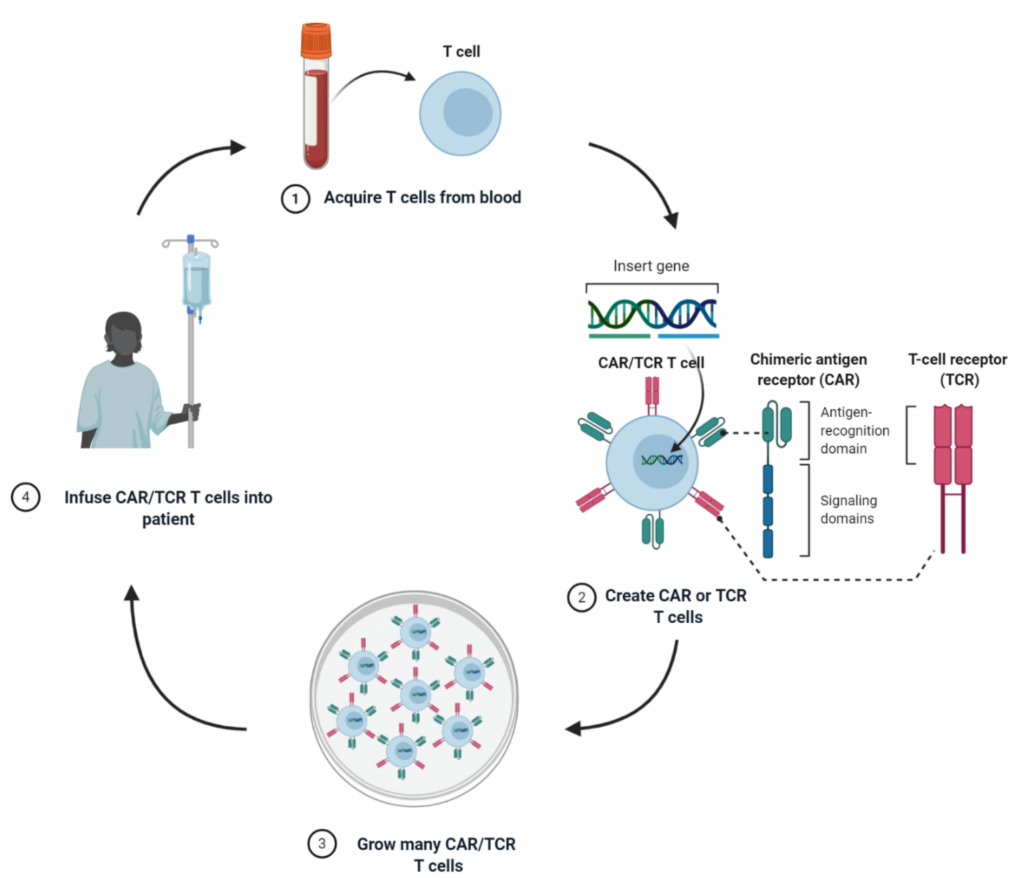
Figure 1. Production of chimeric-antigen receptor (CAR) / T-cell receptor (TCR) T-cells. T-cells are isolated from the blood of a cancer patient. A CAR or TCR is then introduced into the isolated T-cells through viral or non-viral delivery. CAR / TCR positive T-cells are then selected and expanded into large numbers before being transfused back into the original cancer